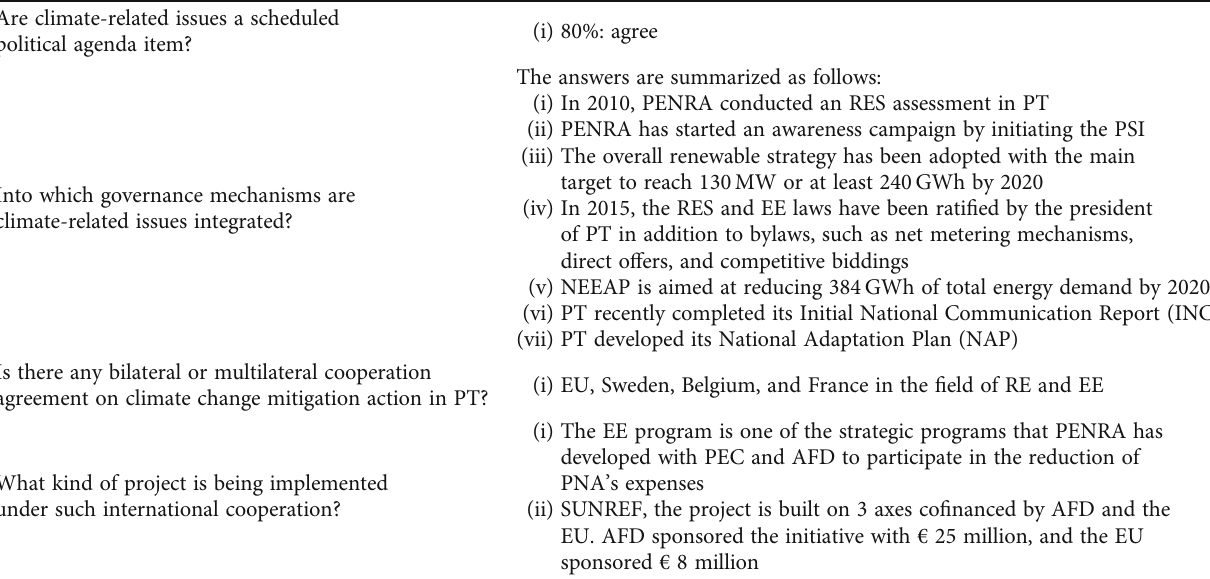
Table 2: Summarization of answers of public institutions to questions related to climate governance.